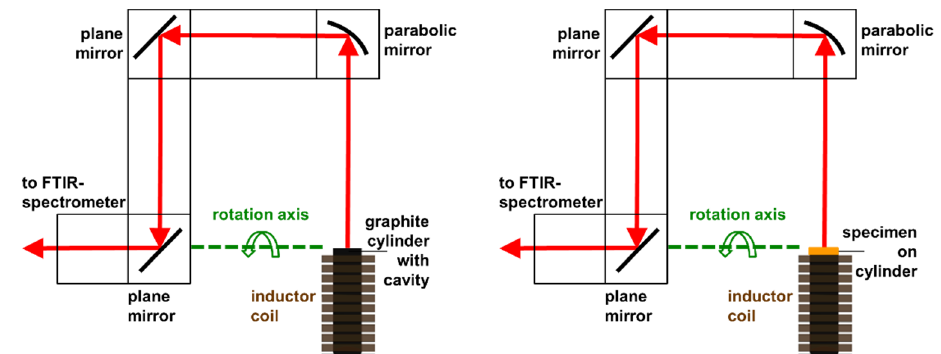
Figure 8. Sketch of the inductor with the movable mirror arm. Configuration for the calibration of the FTIR-spectrometer with a graphite cylinder, which serves as blackbody on the left. Configuration for measuring the emissivity of a specimen, which is heated from the backside, on the right.